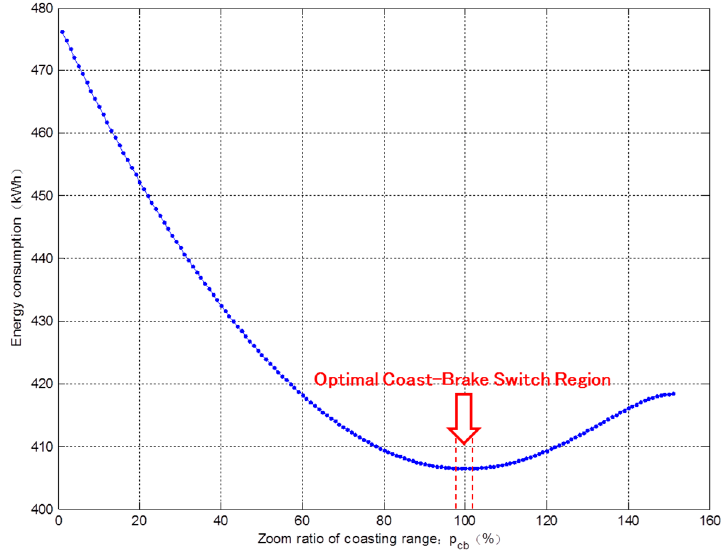
Figure 5. Energy consumption change over different coasting ranges.